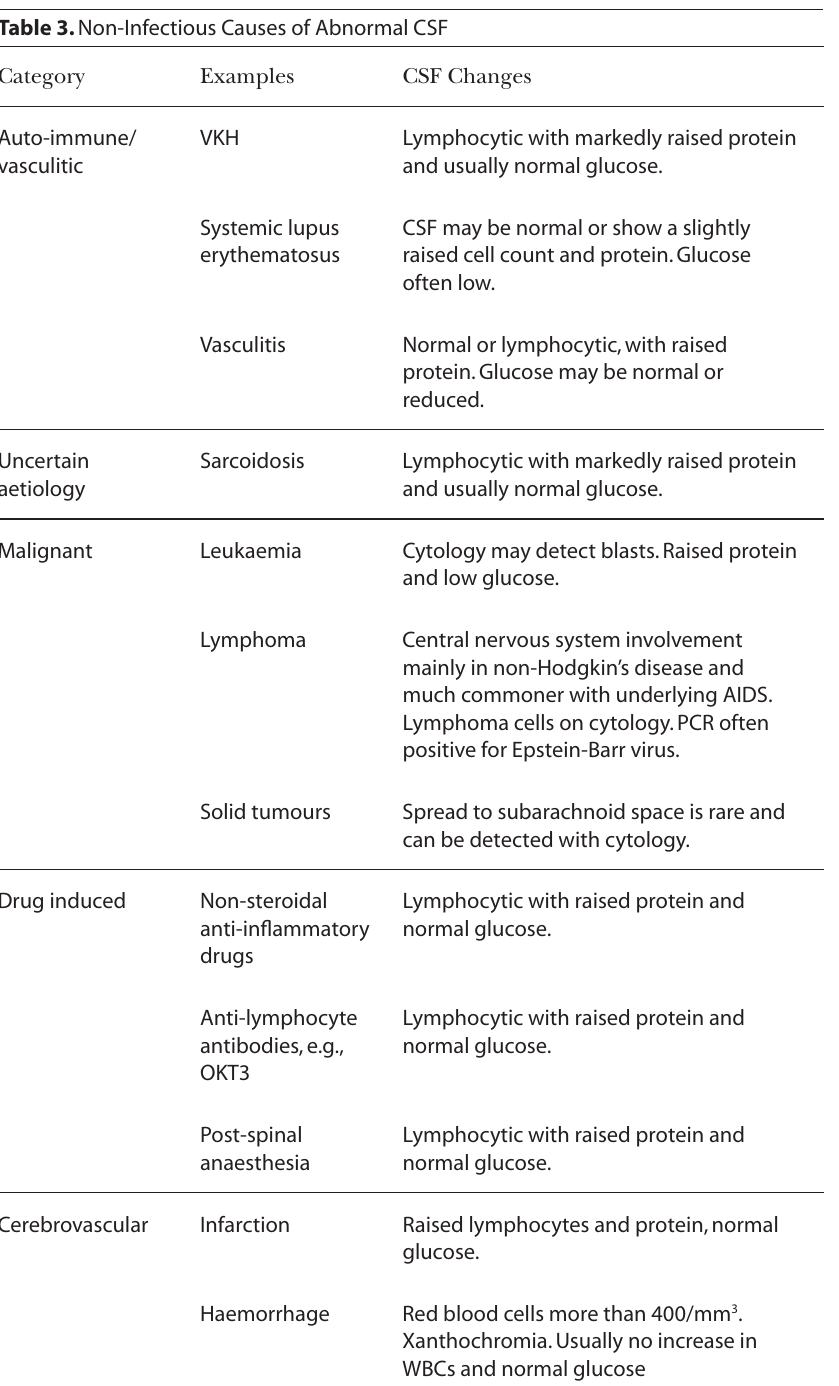
Figure 4. Total Retinal Detachment, Where Whole Retina is Grey in